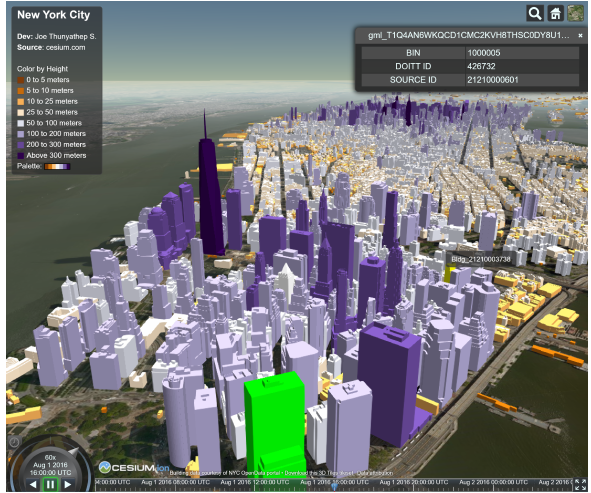
Figure 5. 3D Visualization of New York City model on Cesium